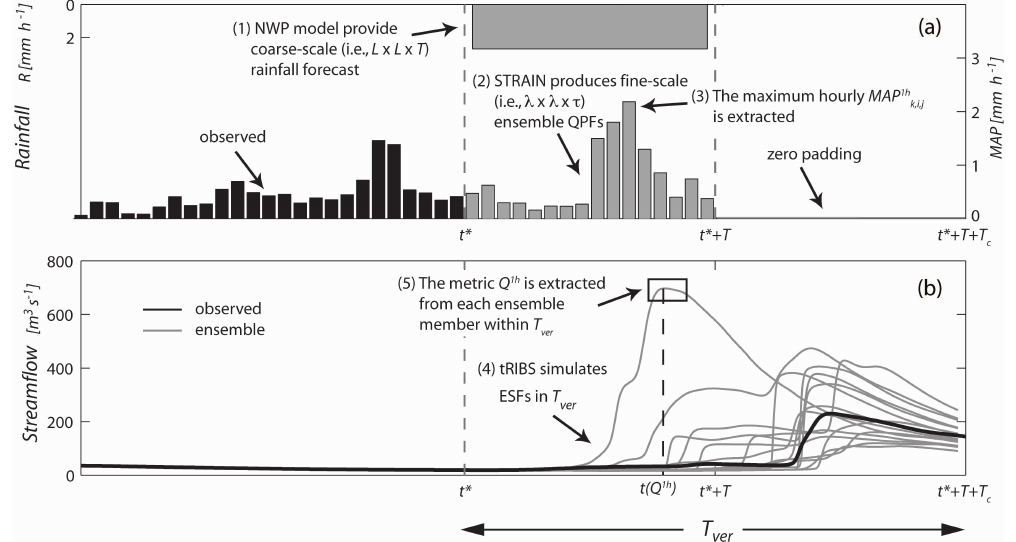
Fig. 3. Event-based approach for the hydrometeorological hindcasts. In (a) : (1) precipitation is observed up to t ∗ , when a NWP model issues a coarse rainfall forecast R for the next T hours over the L × L domain, (2) the STRAIN model produces fine-scale ( λ × λ × τ ) consistent ensemble QPFs between t ∗ and ( t ∗ + T ), and (3) the metric MAP 1h used to quantify the dispersion of ensemble QPF is extracted from each i,j,k rainfall member. In (b) : (4) the tRIBS model, forced by the ensemble QPFs from t ∗ to ( t ∗ + T ) and zero padding rainfall from ( t ∗ + T ) up to ( t ∗ + T + T c ), simulates the ESFs, and (5) the metric Q 1h used to measure the ESF dispersion is extracted from each streamflow member k,i,j within the time window T ver at time t(Q 1h ) . Note that the zero-padding interval in the rainfall input is added to include the delay in the streamflow response due to the basin response